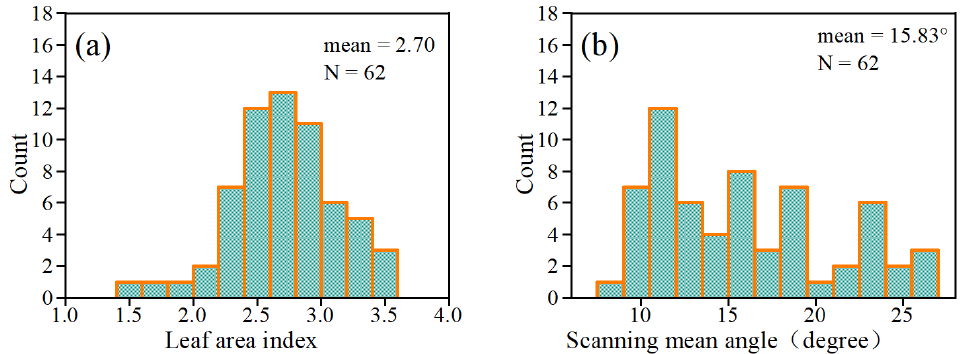
Figure 7. Distribution of the effective leaf area index ( a ) and scanning mean angle ( b ).